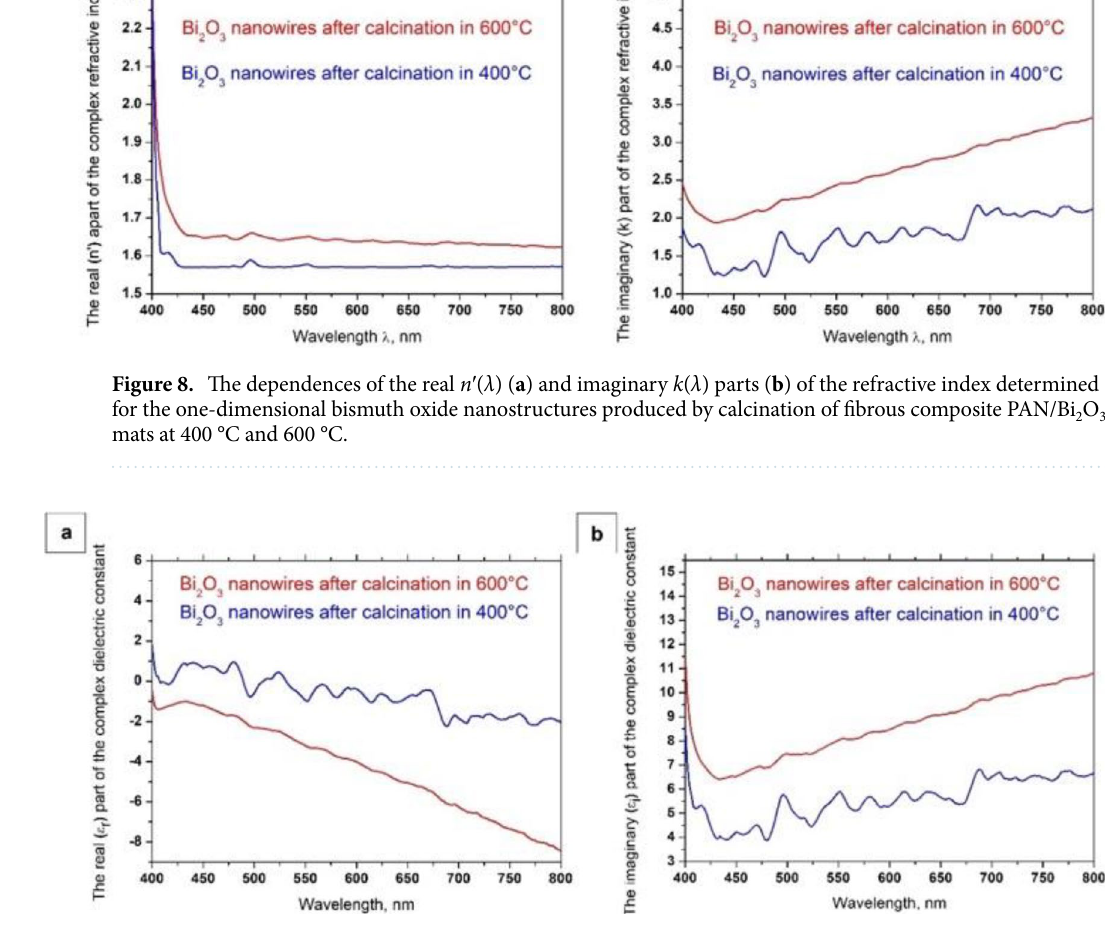
Figure 9. The dependences of the real ε r ( λ ), ( a ) and imaginary ε i ( λ ) parts ( b ) of the dielectric constant for the one-dimensional bismuth oxide nanostructures produced by calcination of fibrous composite PAN/Bi 2 O 3 mats at 400 °C and 600 °C.